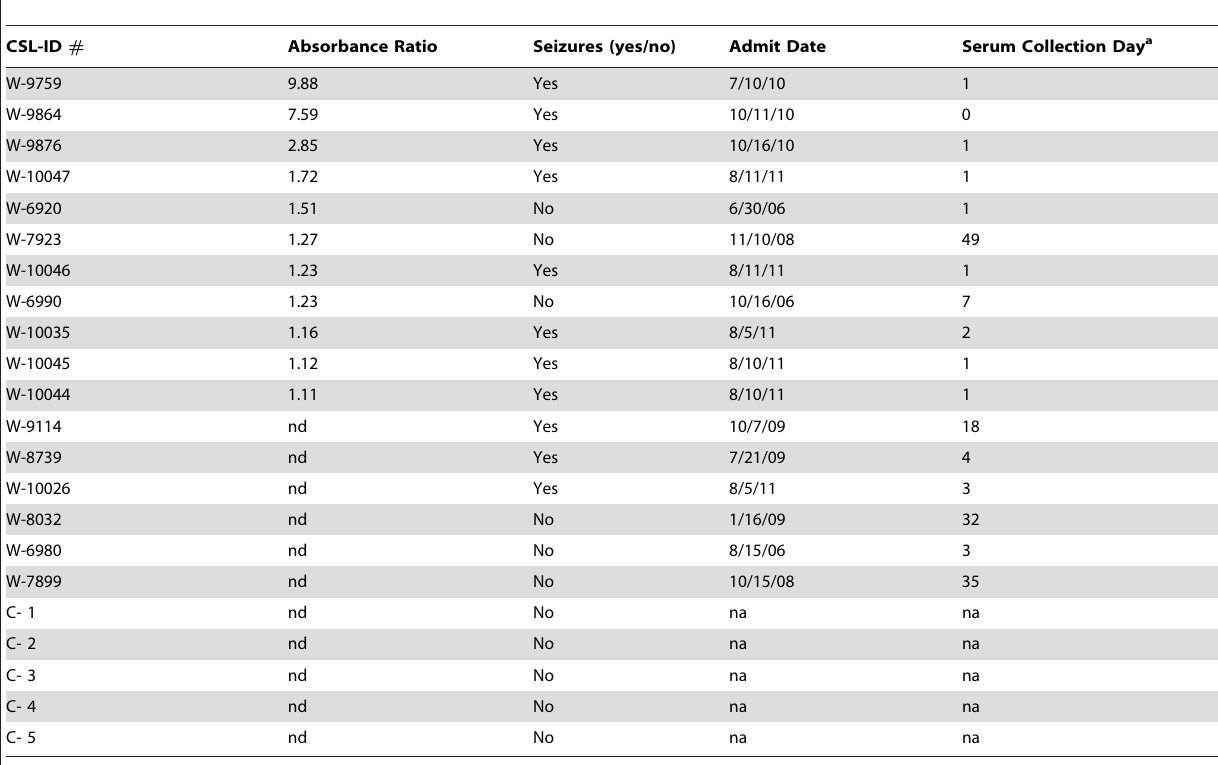
Table 1. Confirmation of the presence of a domoic acid (DA)-specific antibody in naturally exposed California sea lion ( Zalophus californianus ) serum samples as detected via an indirect enzyme-linked immunosorbent assay (ELISA).